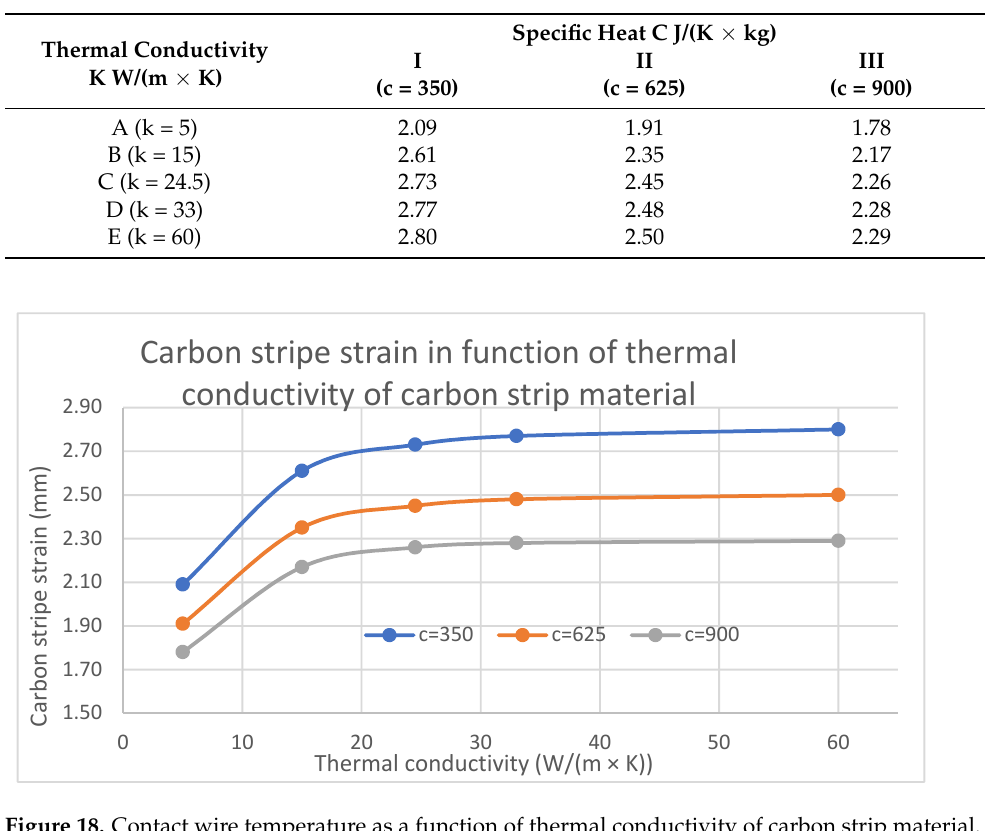
Table 7. Summary of the influence of the thermal conductivity and specific heat coefficient on the maximum values of relative deformations of the contact strip.